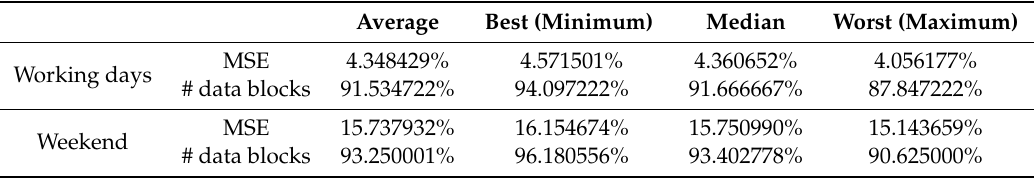
Table 4. Numerical improvements over base polynomials.